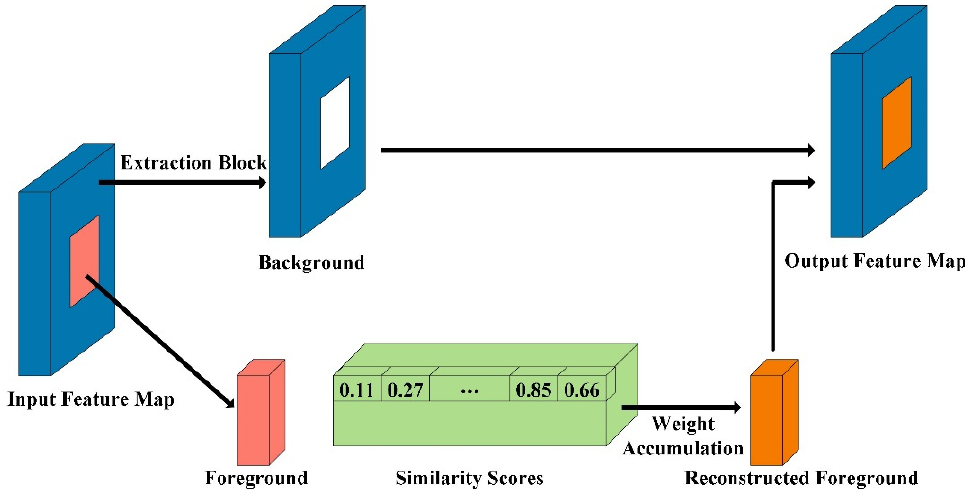
Figure 5. Illustration of CAM.